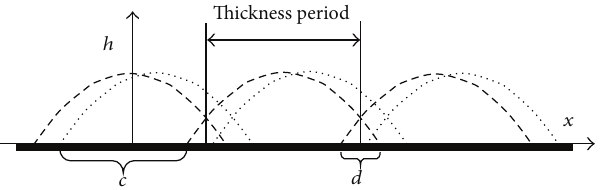
Figure 17: Typical sketch of peripheral painting